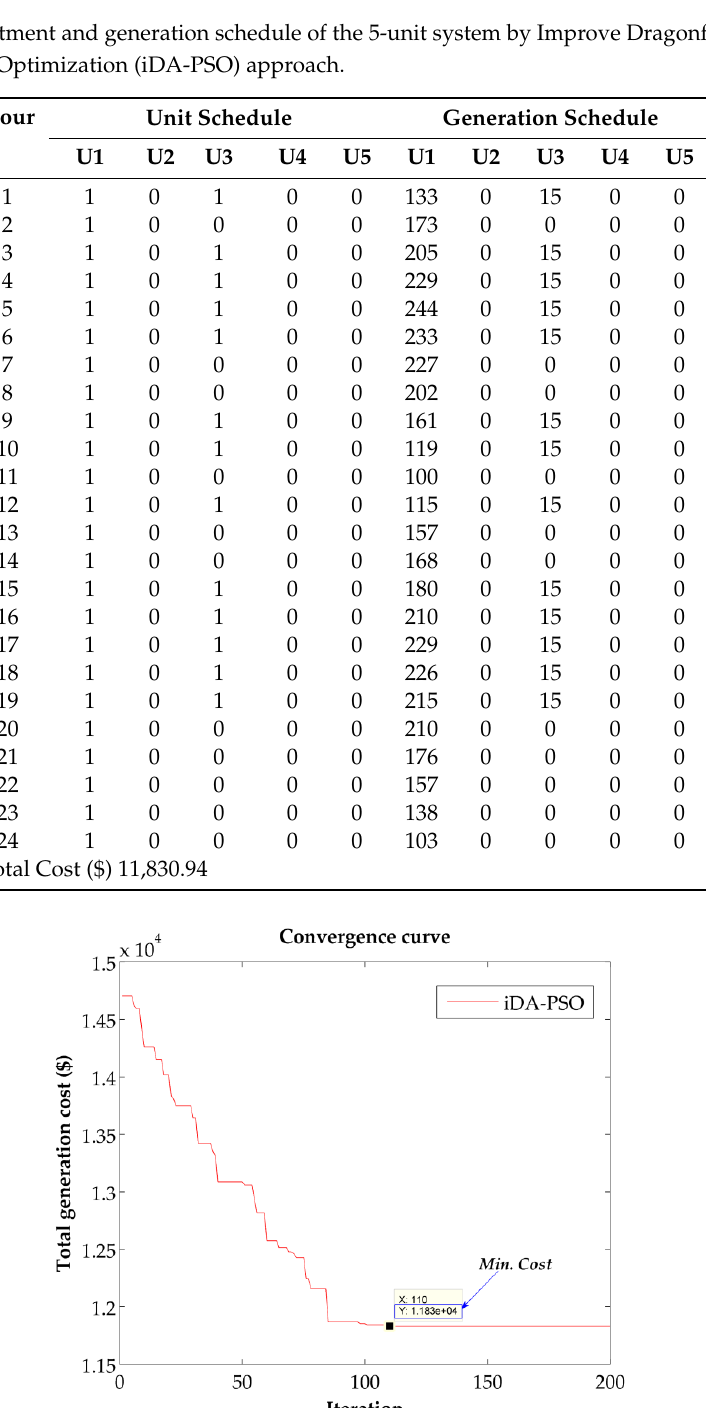
Figure 2. Convergence curve of the iDA-PSO approach for the 5-unit system .